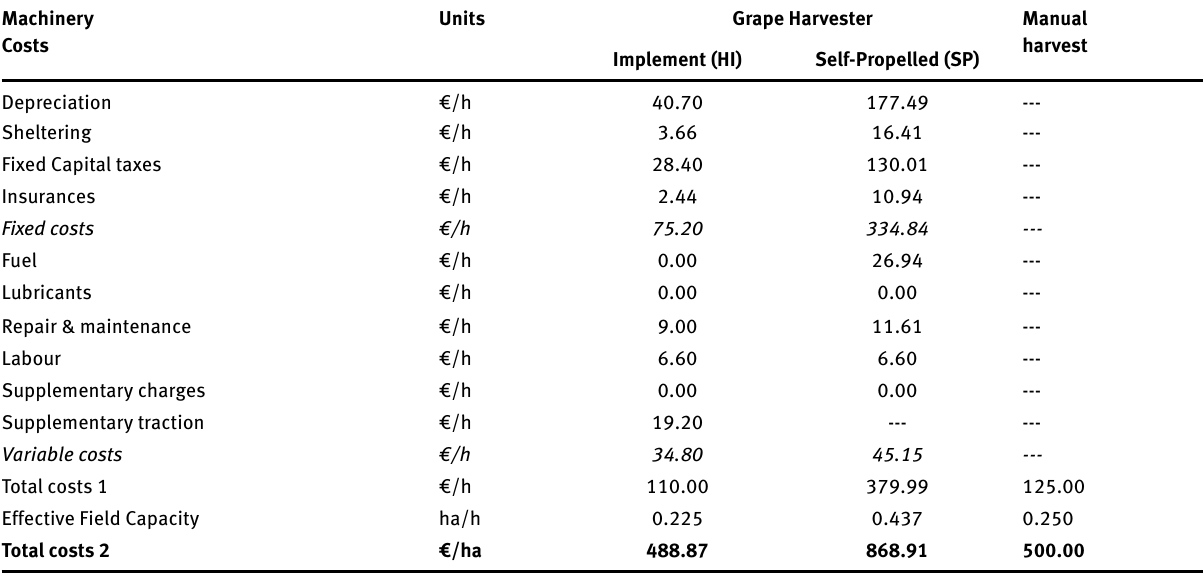
Table 5: MACHoice output presenting the grape harvesting costs per hour for manual and mechanical alternatives of grape harvester for a vineyard size of 30